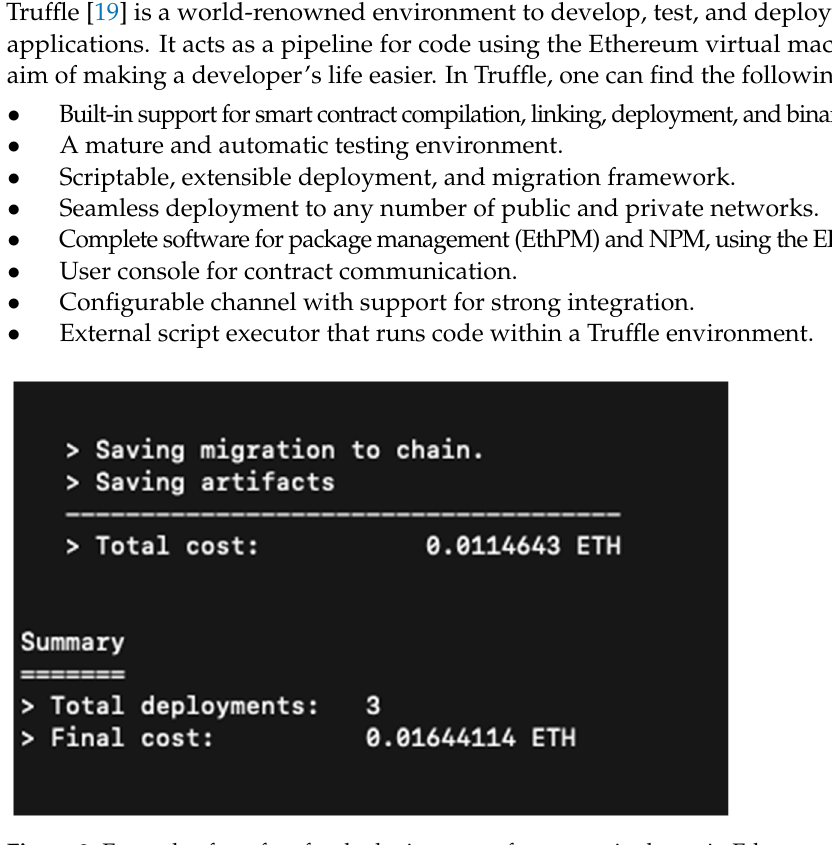
Figure 3. Example of gas fees for deploying a set of contracts in the main Ethereum network.